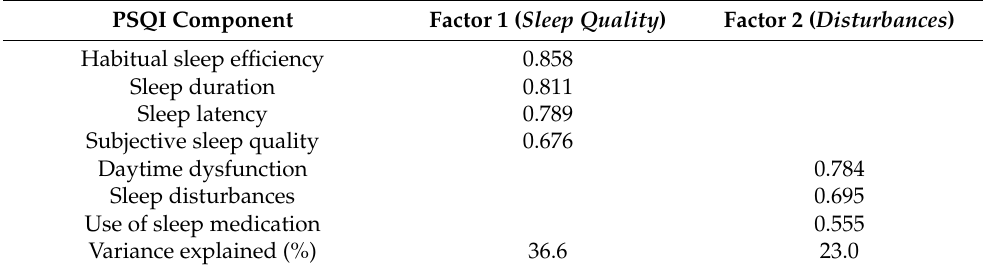
Table 3. Exploratory factor analysis for PSQI.